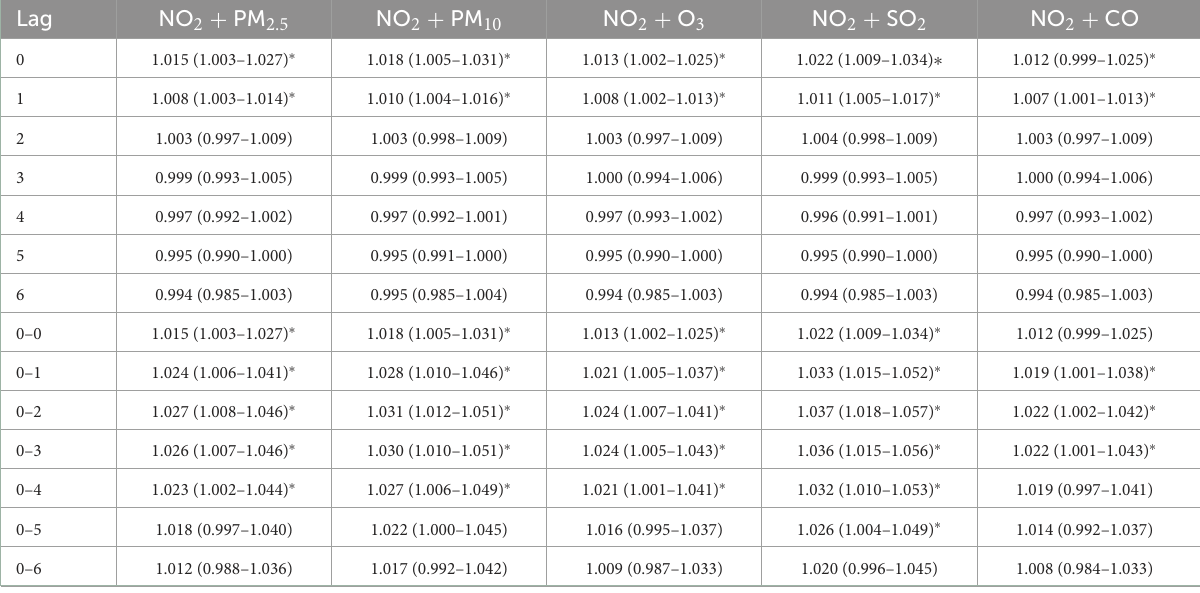
TABLE 2 The association between an increase of 10 µ g/m 3 of NO 2 and CHD admission in Hefei, 2014–2021 (dual pollutant model).